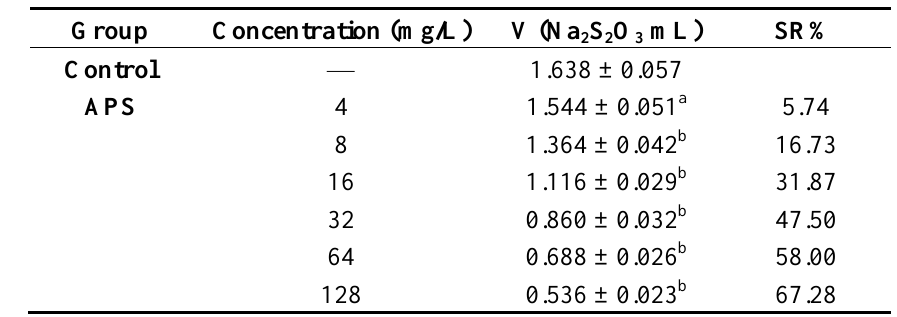
Table 4. The scavenging effect of APS on H S.D. and statistical differences between groups were analyzed by one-way analysis